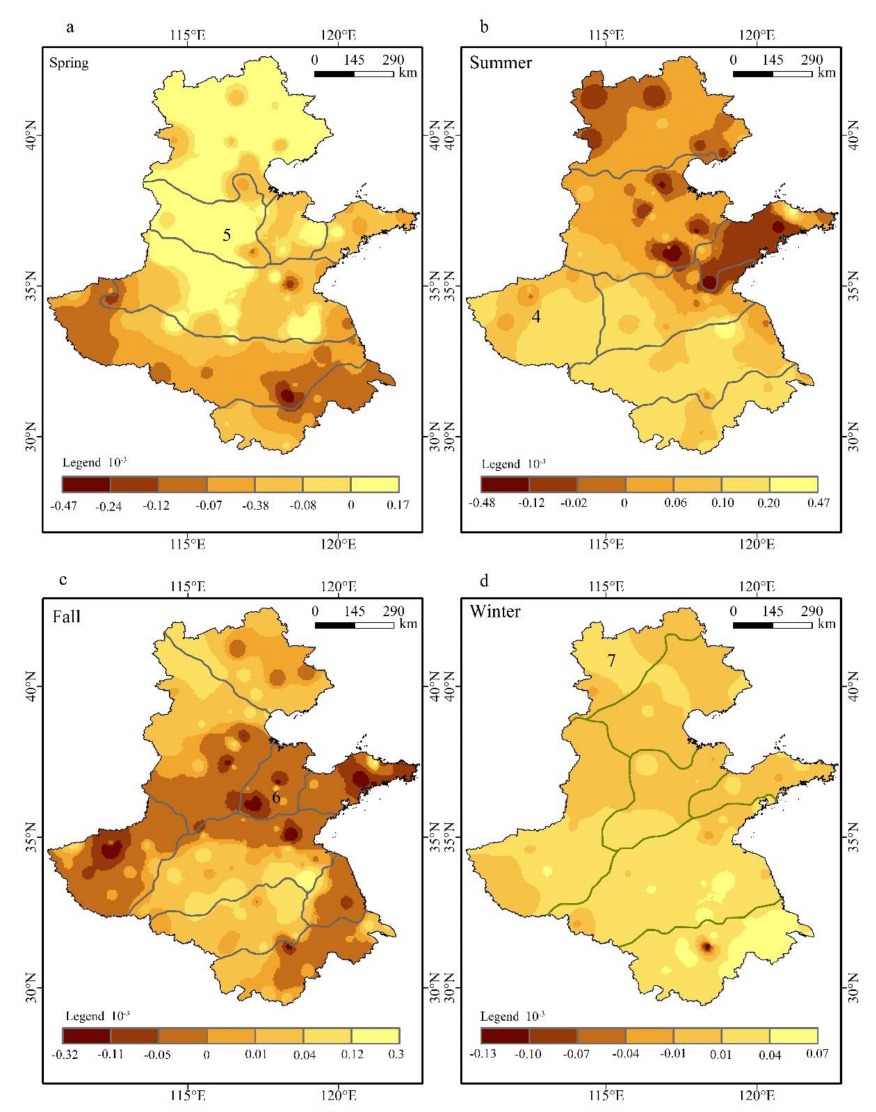
Figure 7. Trends for Standardized Precipitation Evapotranspiration Index (SPEI) between 1960 and 2017 for ( a) (spring), ( b ) (summer), ( c ) (fall), and ( d ) (winter). Only sub-regions with statistically significant trends using the modified Mann–Kendall test (significance level 0.05) are indicated in the sub-region code. The trend is interpolated by inverse distance